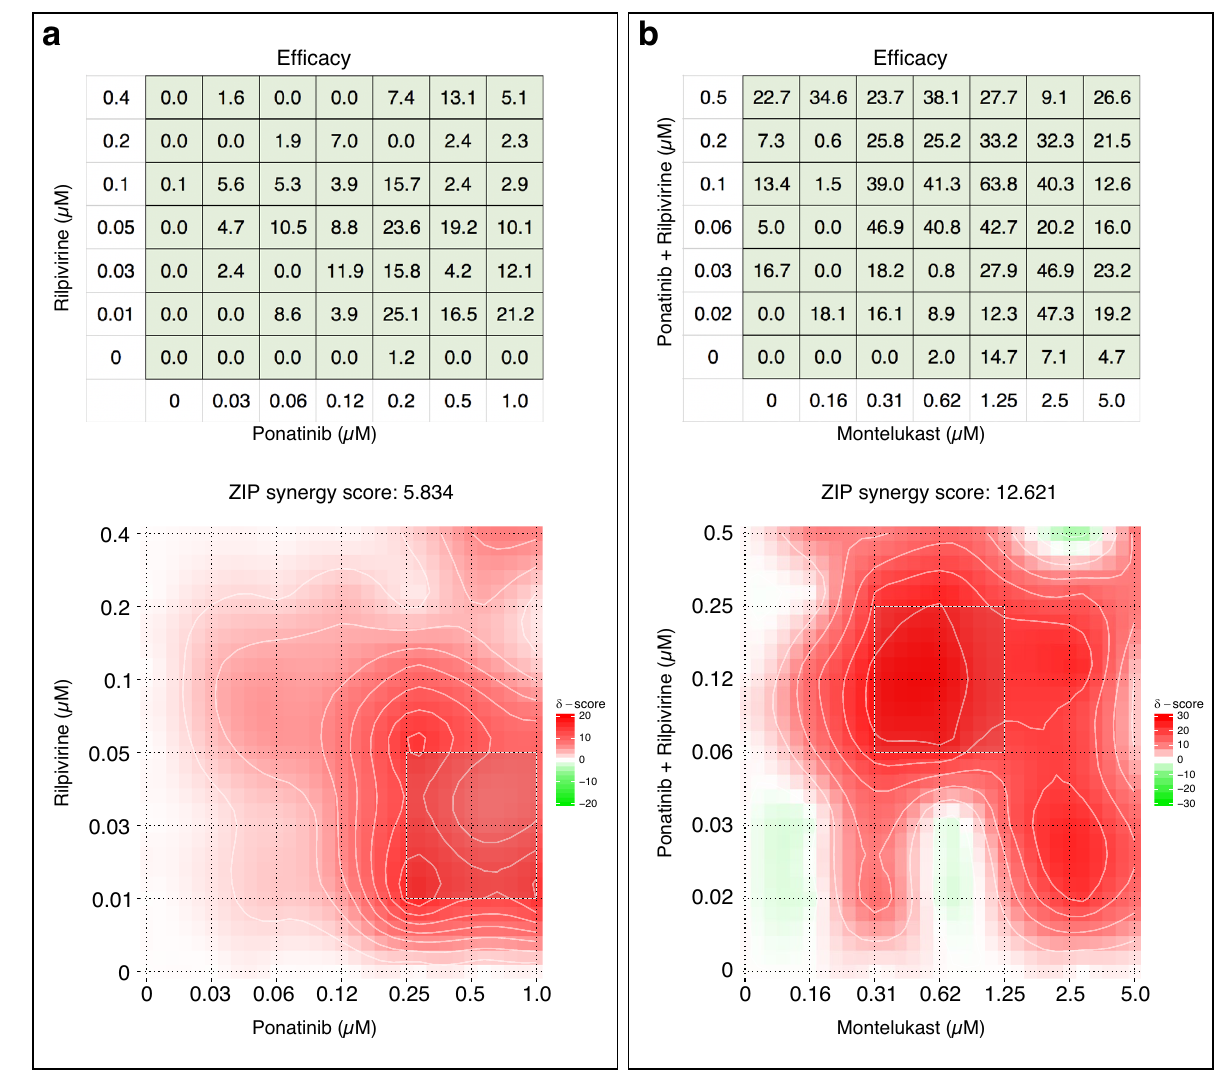
Figure 4. Synergistic interactions among Ponatinib, Rilpivirine, and Montelukast. Combinations of drugs were applied to Nsp1-transfected H1299 cells, and Efficacies was determined. The Efficacy at the indicated concentrations of each drug were used to visualize synergy using an online tool 36 . Areas demarcated in red represent synergistic combinations as shown in the scale quantitated by the ZIP method 36,37 . ( a ) Data were pooled from triplicate experiments to generate the Efficacy table and Synergy plot of Ponatinib and Rilpivirine. ( b ) Efficacy table and Synergy plot between a combination of Ponatinib + Rilpivirine at a molar ratio of 2.5 to 1, and Montelukast. The concentration for the Ponatinib + Rilpivirine combination reflects that of Ponatinib